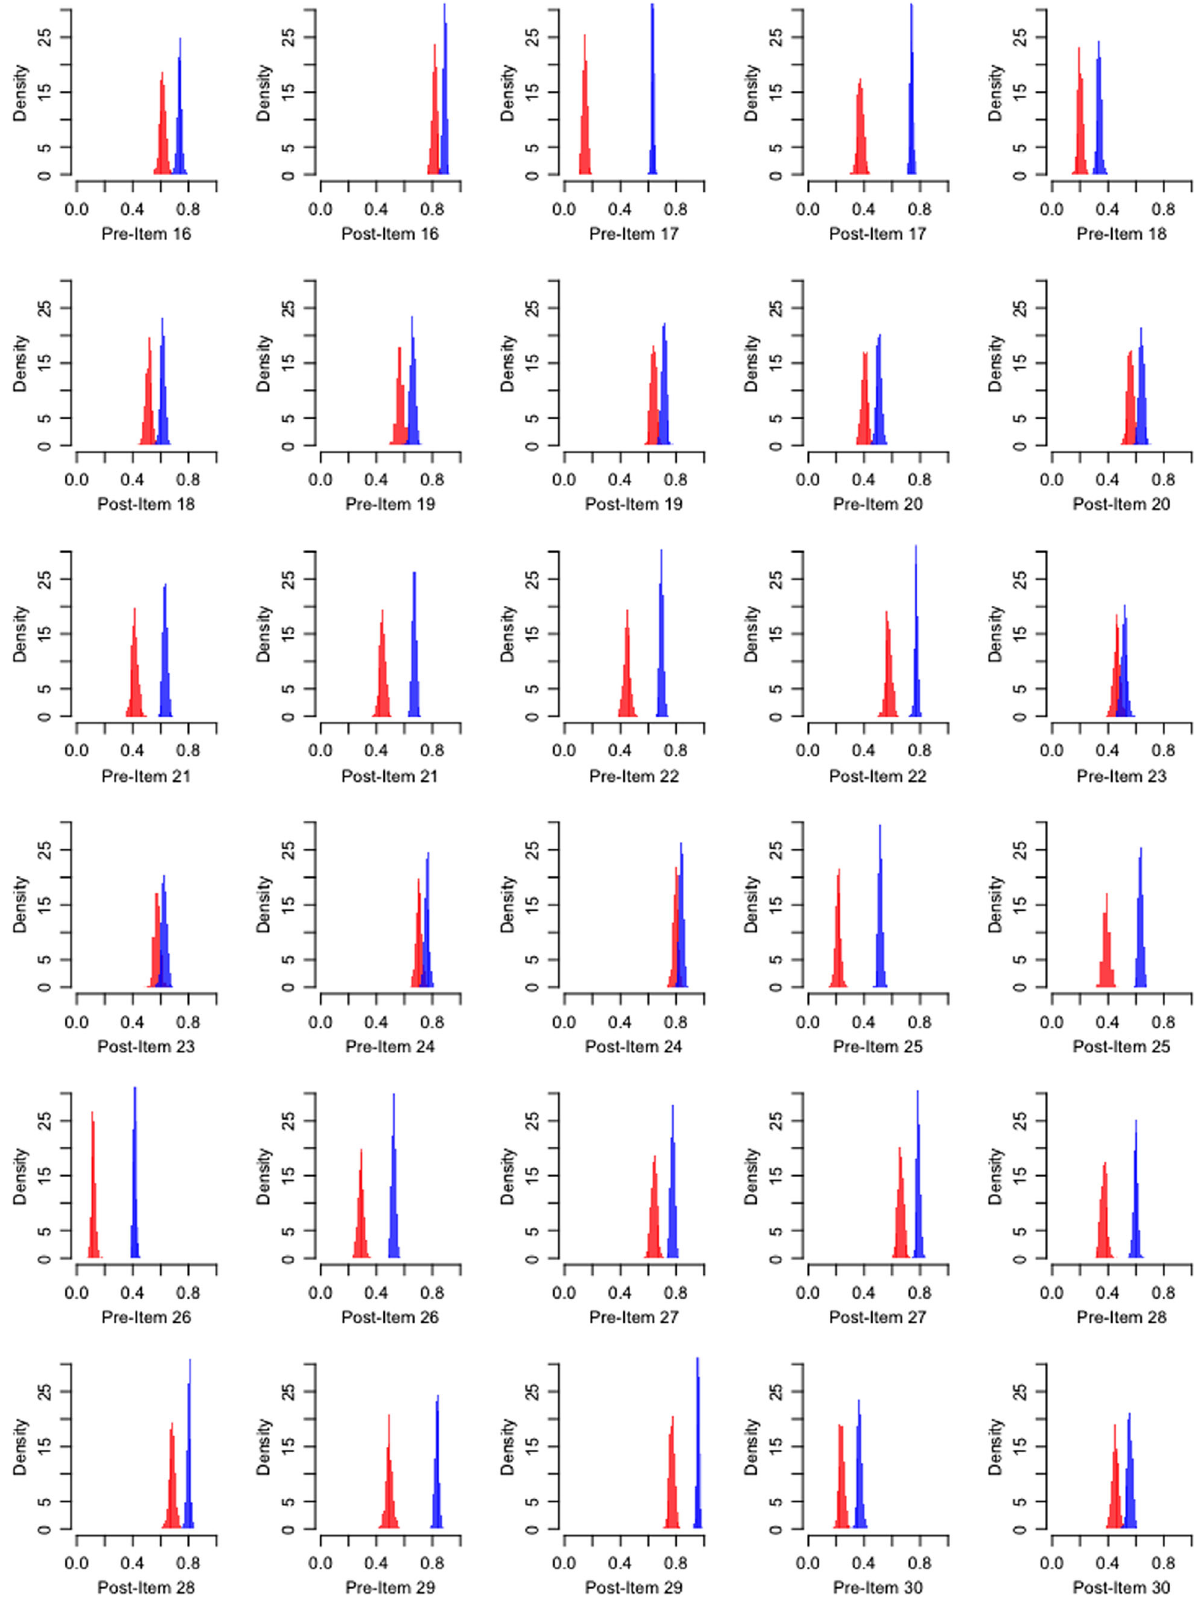
FIG. 8. Average item scores for questions 16 – 30 pre and post-test. Averages from dichotomous scoring are in red and the partial credit scoring item averages are in